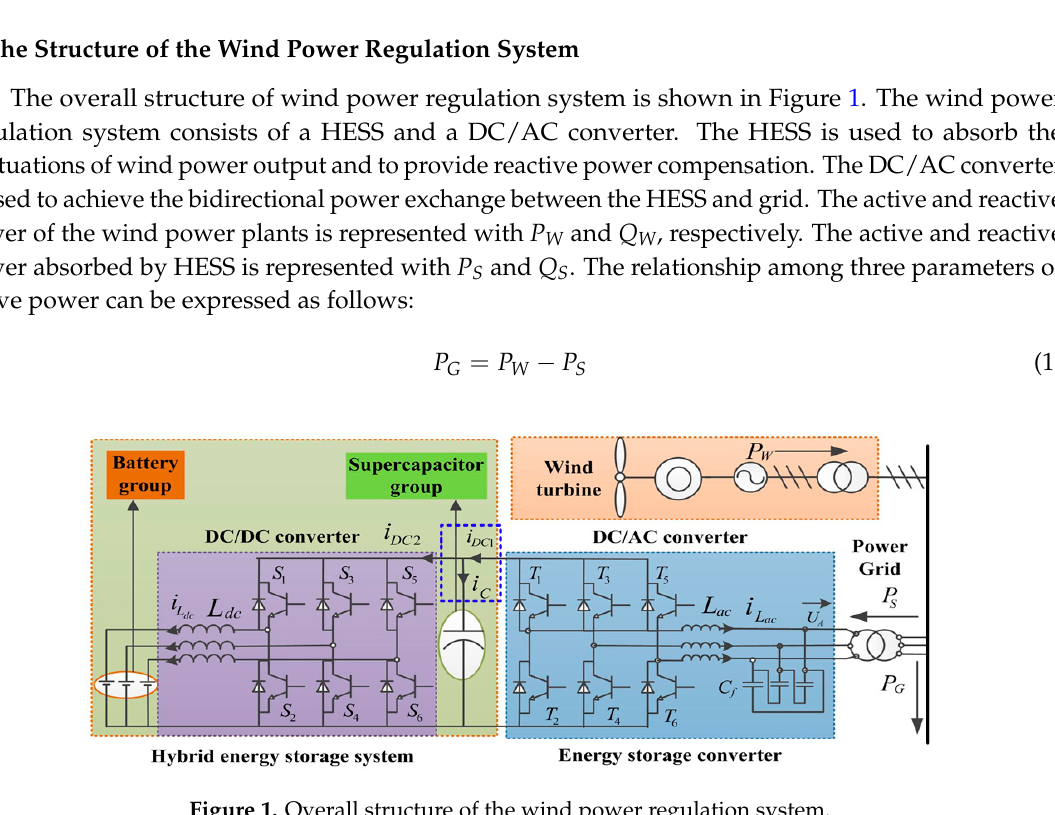
Figure 1. Overall structure of the wind power regulation system.